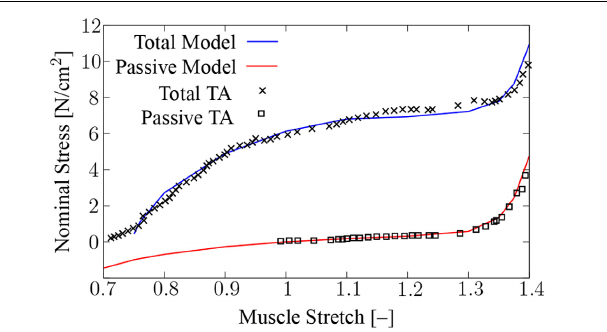
FIGURE 6 | Muscle stress-stretch relation. Shown are the passive and total stresses computed using the coupled chemo-electro-mechanical model, and the experimental data of rat TA muscle (Hawkins and Bey, 1994). Simulations are carried out at stretches varying from 0.8 to 1.4 in steps of size 0.1, and at λ f = 0 . 75, 0.76, 1.35, and